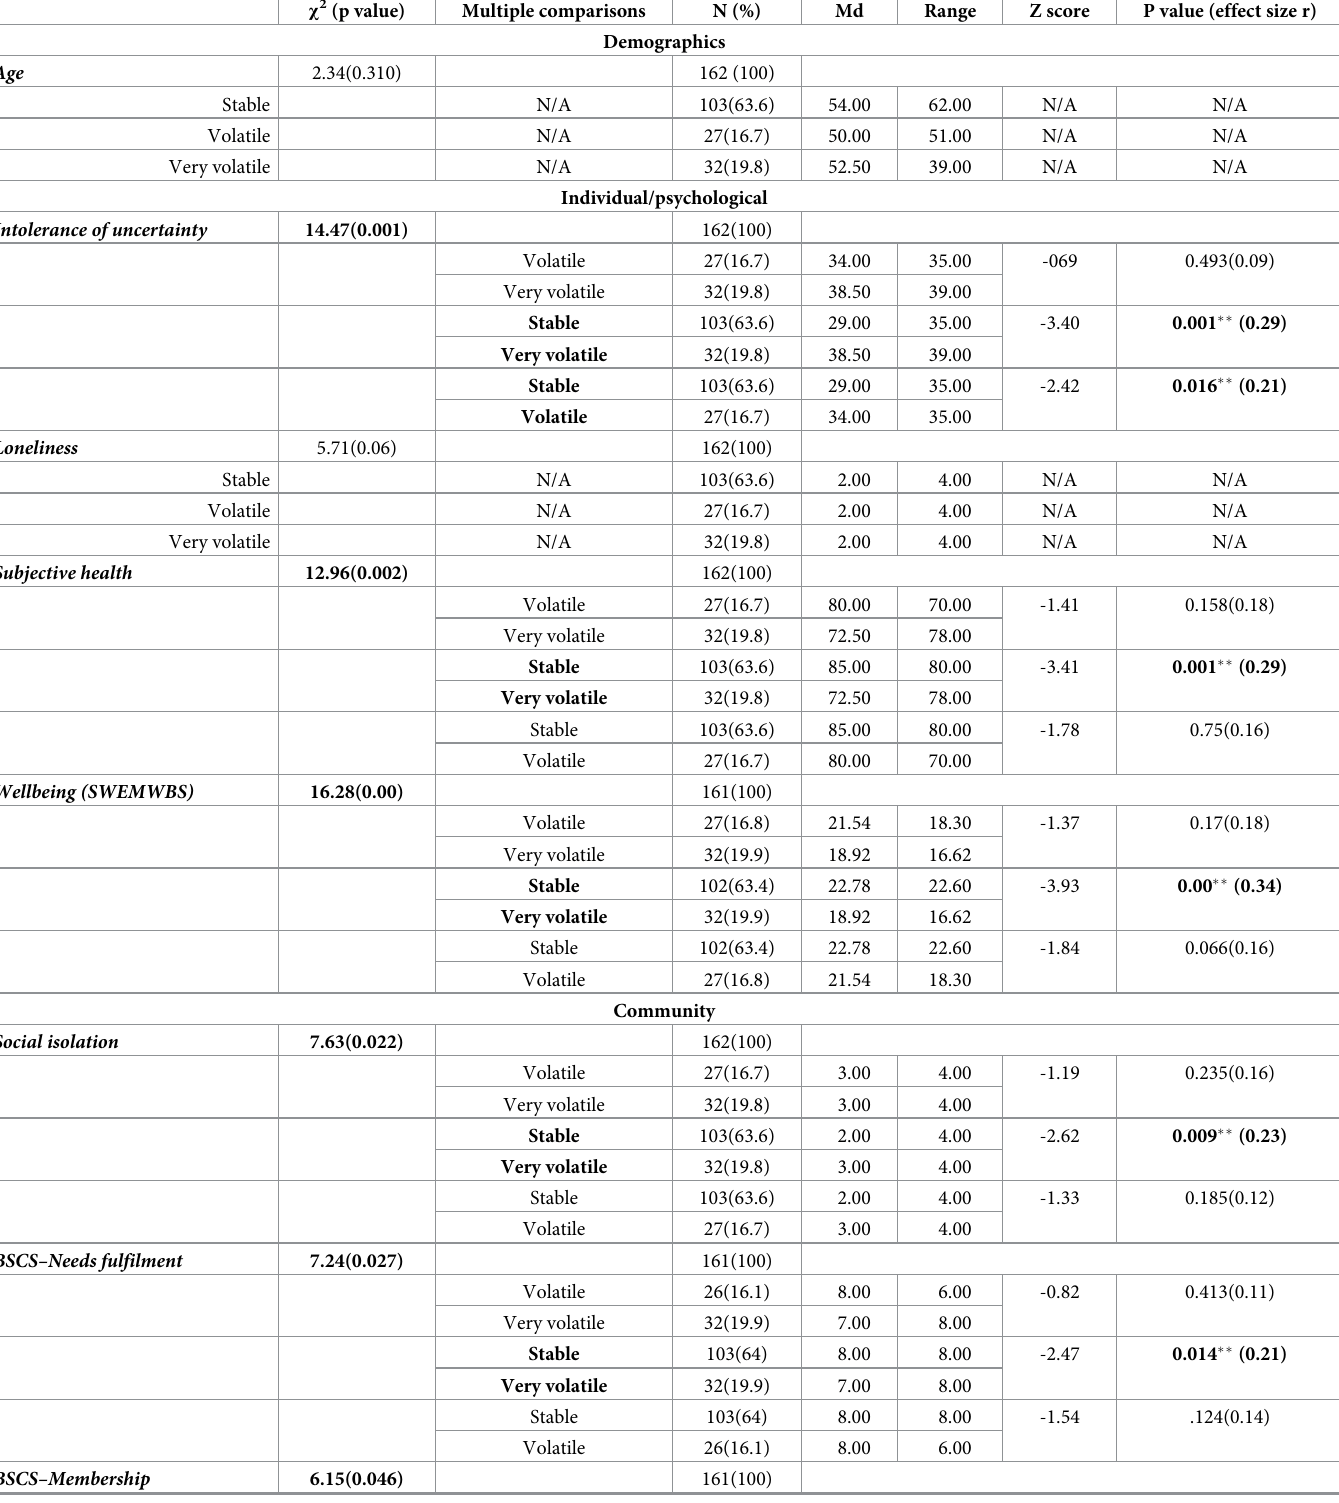
Table 5. Differences between the ‘stable’, ‘volatile’, and ‘very volatile’ groups (analysis of continuous variables). Significant differences are